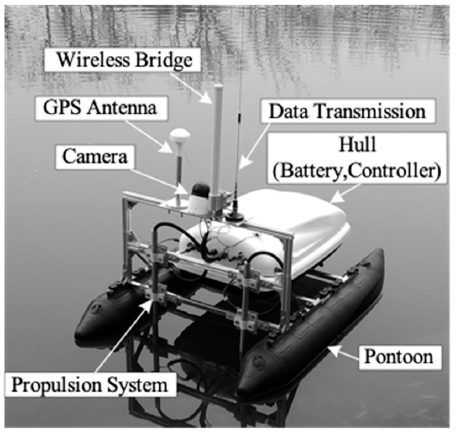
Figure 1. The FAS-01 USV.